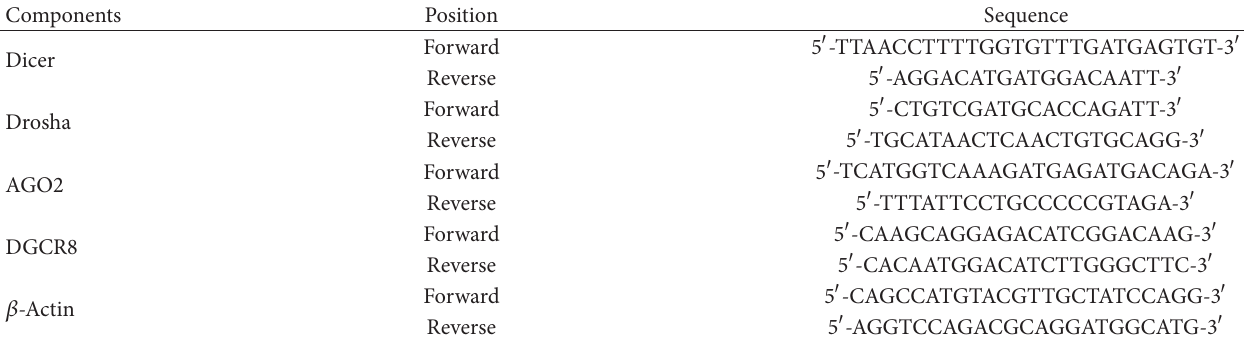
Table 1: Primer sequences of miRNA machinery components used in quantitative